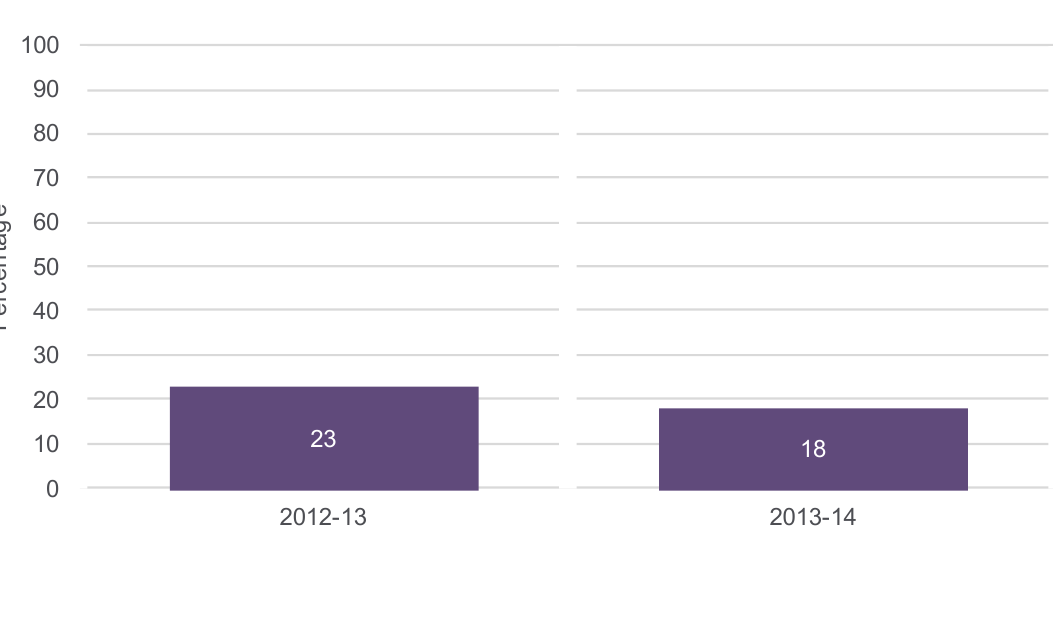
- Table 7: Whether people are aware of or involved in social action in their local area at least once in the last year by sex and age, 2012-13 to 2013-14